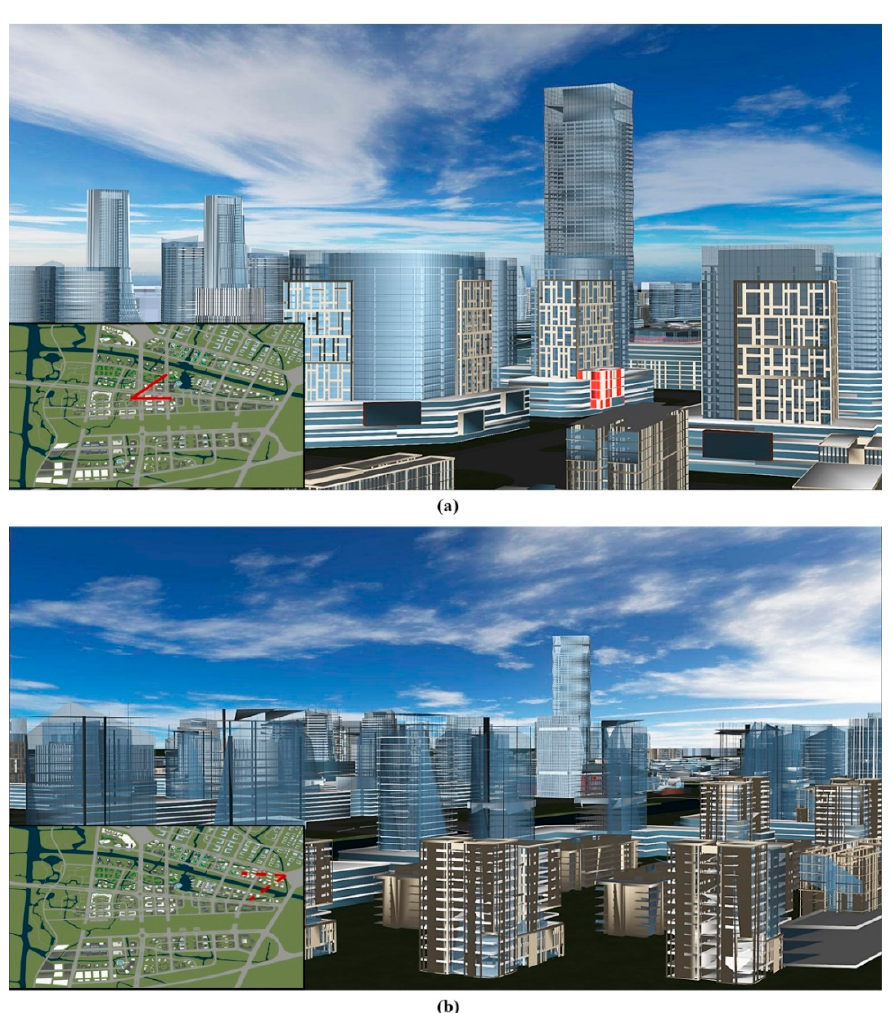
Figure 11. View-dependent effect of city scene: ( a ) The effect observed from the current viewpoint; ( b ) the state at the other end of the city.